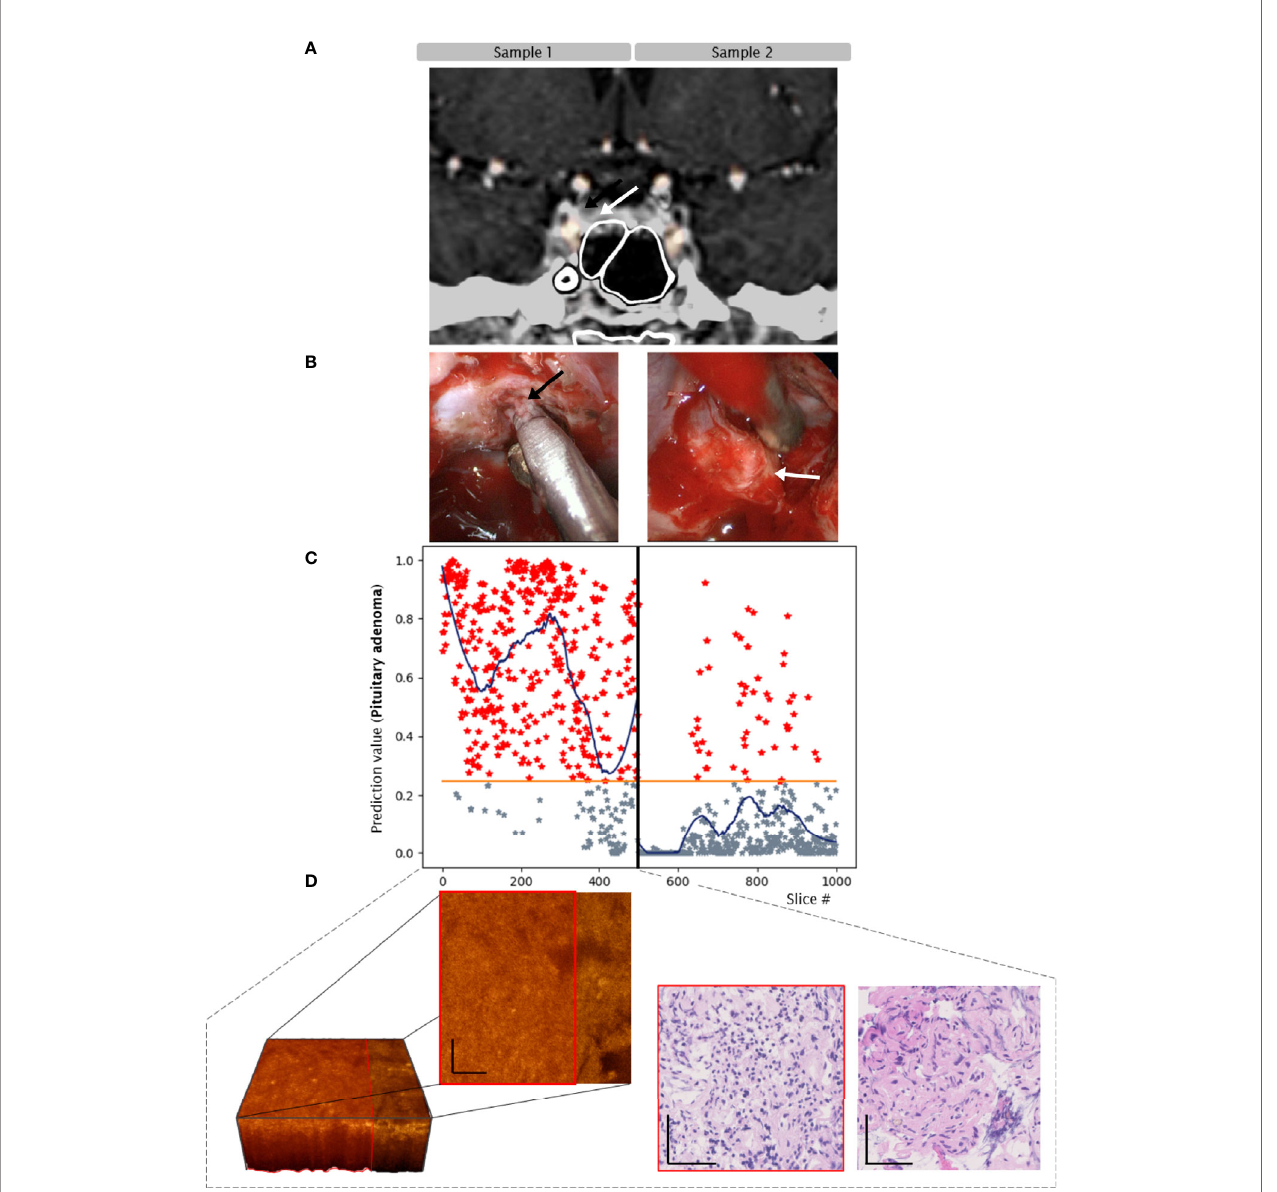
FIGURE 4 | Case 3. Convolutional neuronal network assessment of OCT images of samples of pituitary adenoma (black arrow) and adjacent gland (white arrow). (A) MRI, 8mm microadenoma. (B) intraoperative imaging. (C) Diagram of pituitary adenoma probability. X axis: number of each classi fi ed slice (500 per sample). The orange line indicates the classi fi cation threshold for pituitary adenoma/non-adenoma. The blue curve indicates an average of 150 slices to visualize the network prediction. (D) OCT 3-dimensional visualization of the sub-volume of sample 1 – pituitary adenoma (red box) with connective tissue, H/E slices of segements of pituitary adenoma and fi brous tissue. Scale bars: 50